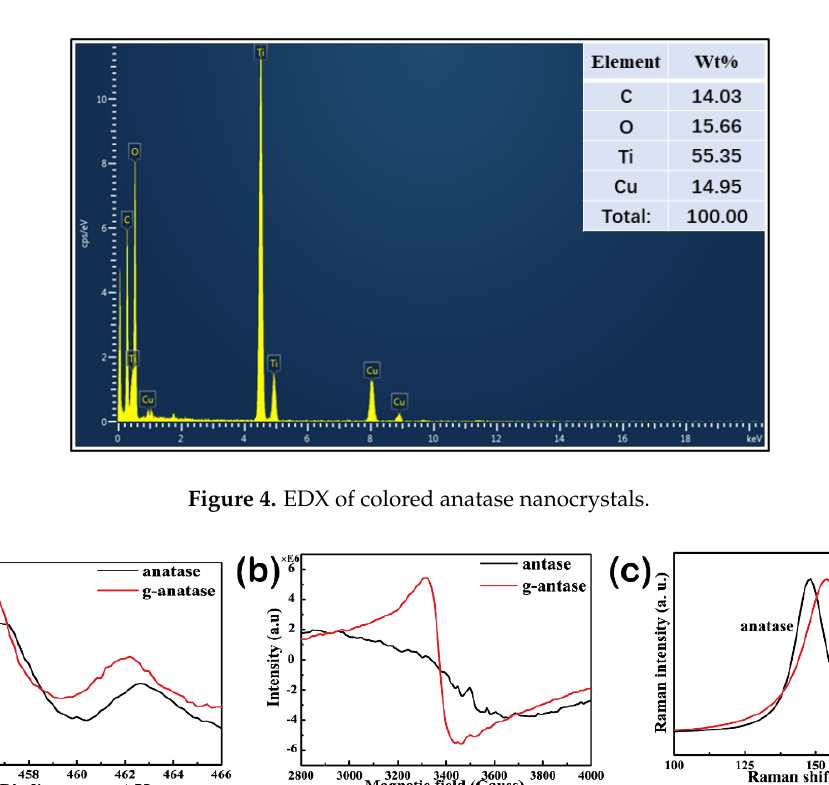
Figure 3. ( a , c ) TEM and ( b , d ) HRTEM images of anatase and colored anatase nanocrystals.